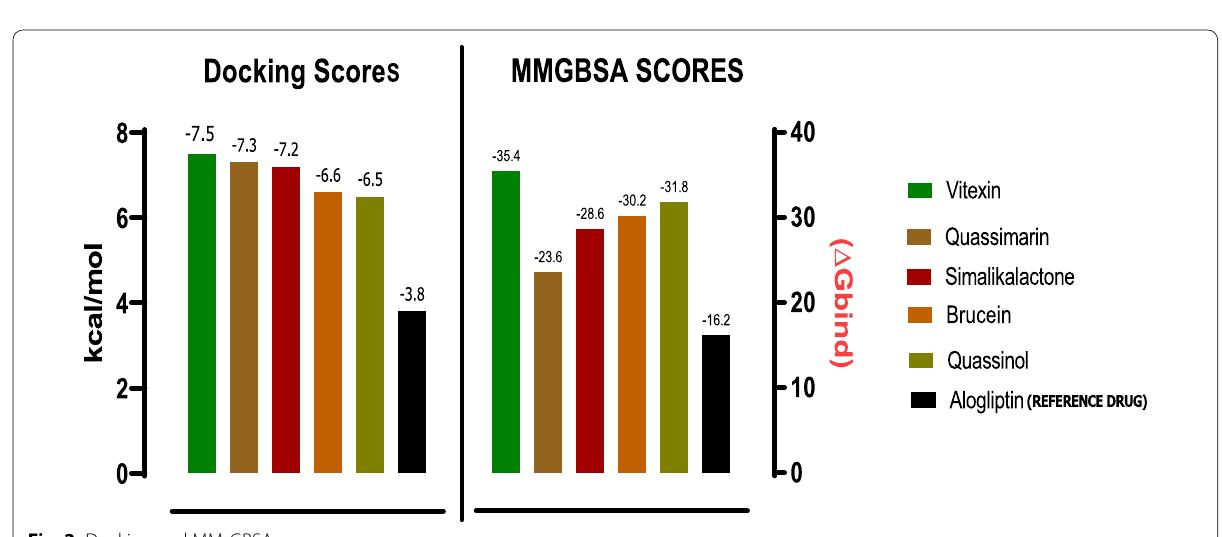
when inhibited, increases the activities of GLP-1 (Gluca- gon Like Peptide-1) and GIP (Gastric Inhibitory Peptide), resulting in increased glucose-mediated insulin secre- tion and suppression of glucagon secretion (Nathan et al. 2007). The protein, DPP-IV was docked to the generated